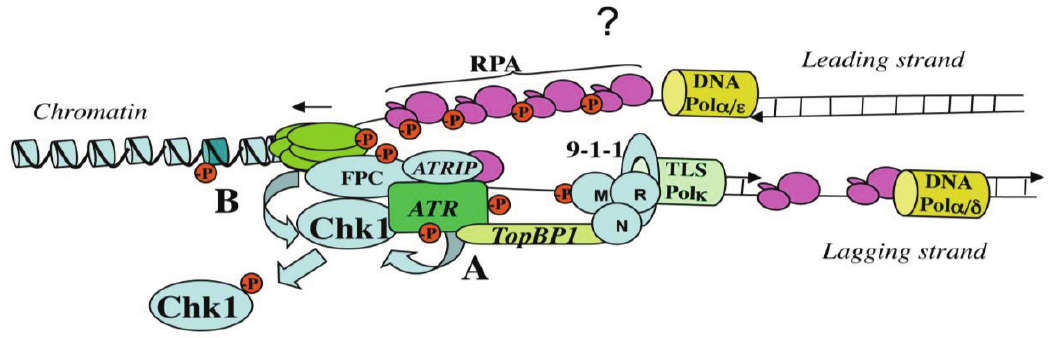
Figure 4. Speculative model for replication checkpoint activation. Replication